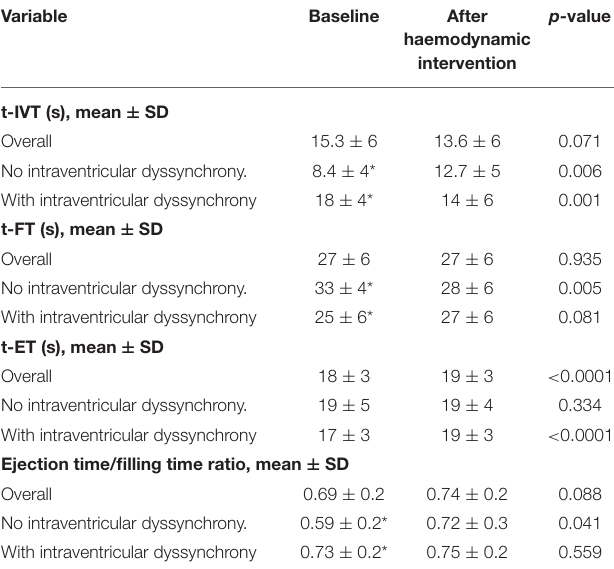
Patients with baseline intraventricular